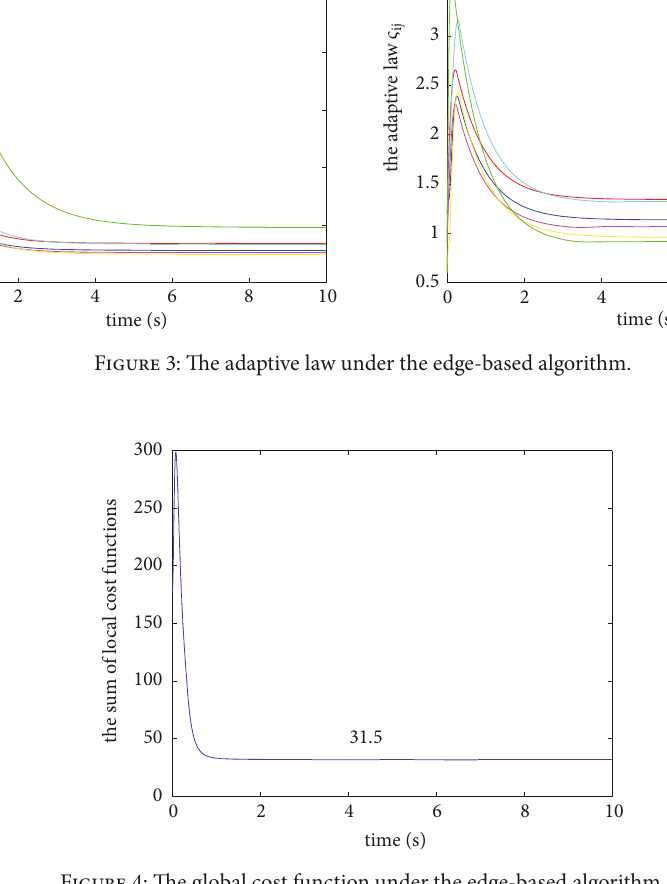
Figure 4: The global cost function under the edge-based